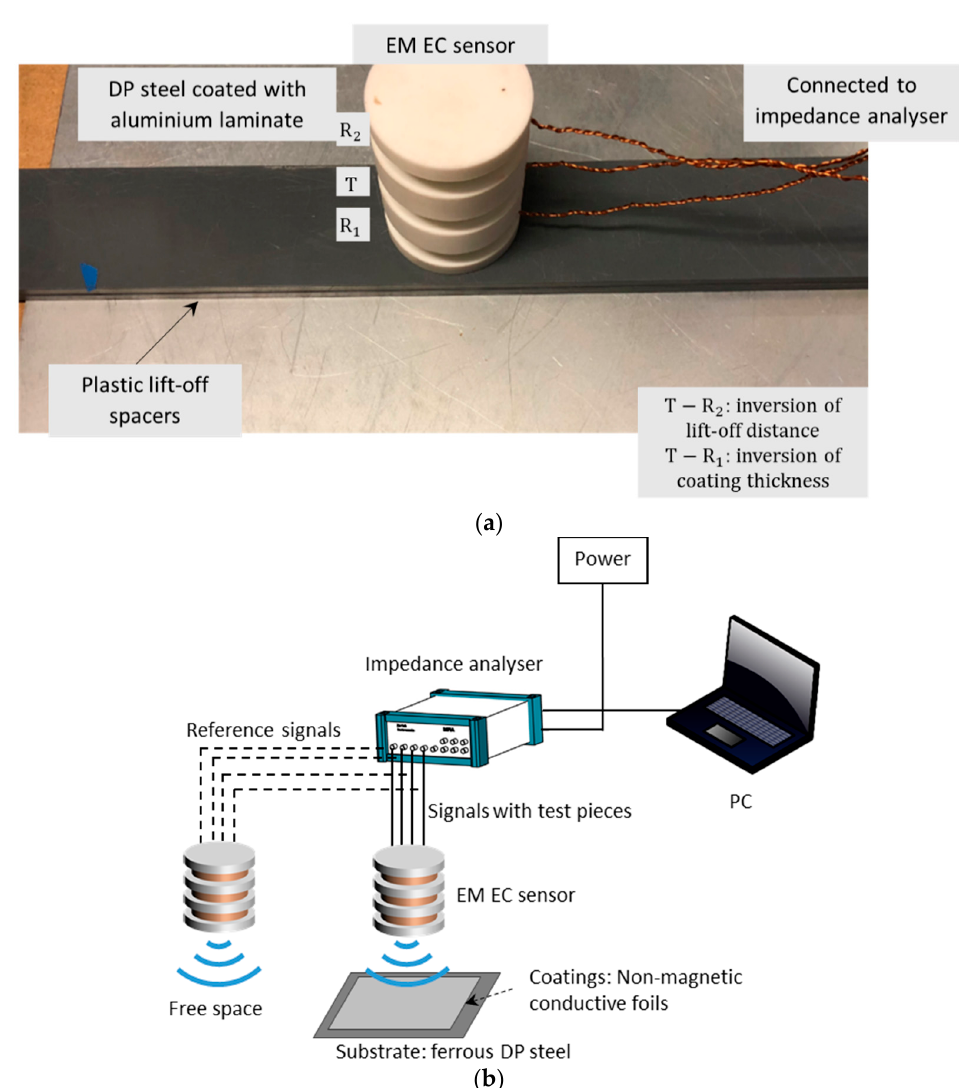
Figure 4. Experimental setup ( a ) sensor placed on the test piece ( b ) sensor connected to the measurement system (imped ‐ ance